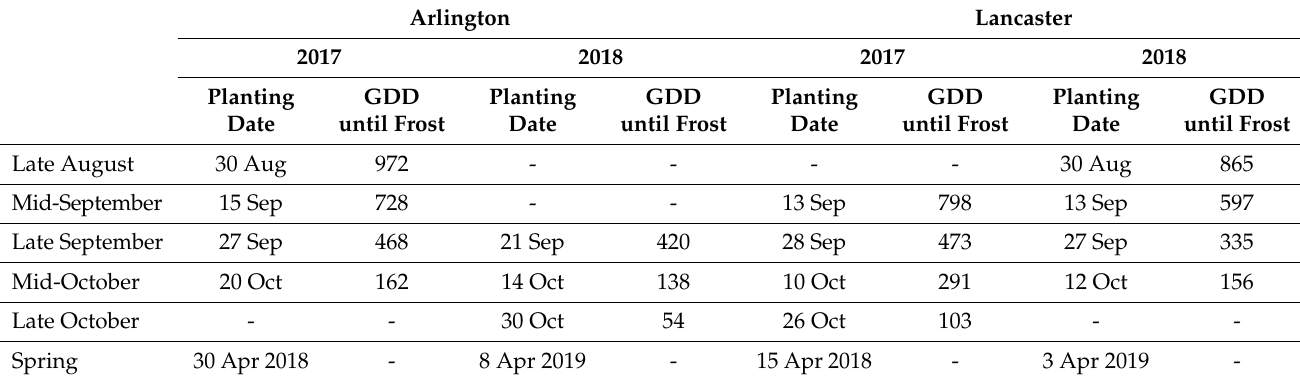
Table 1. Intermediate wheatgrass planting dates and accumulated fall growing degree days (GDD, base 0 °C) until frost for the 2017 and 2018 planting years at Arlington and Lancaster, WI, USA.